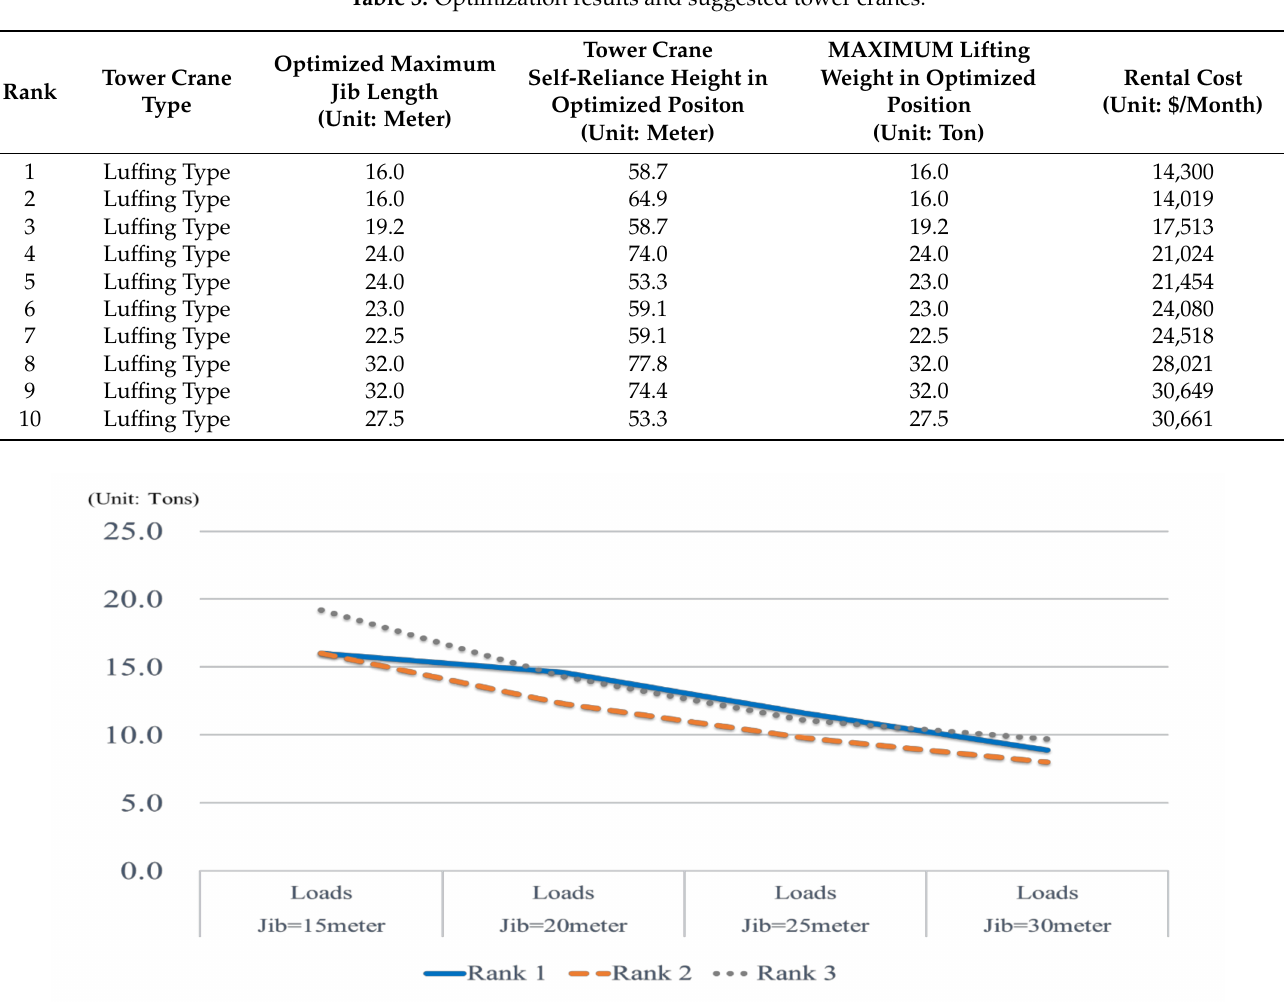
Figure 6. Finding the optimal location for tower crane and trailers (legend: ( a ) is the search area for the genetic algorithm (GA) optimization, ( b ) is the GA search results report summary, ( c ) is the optimal position of the tower crane and trailer after the end of the search (green box: tower crane position, red sphere: trailer position)). Table 3. Optimization results and suggested tower cranes.